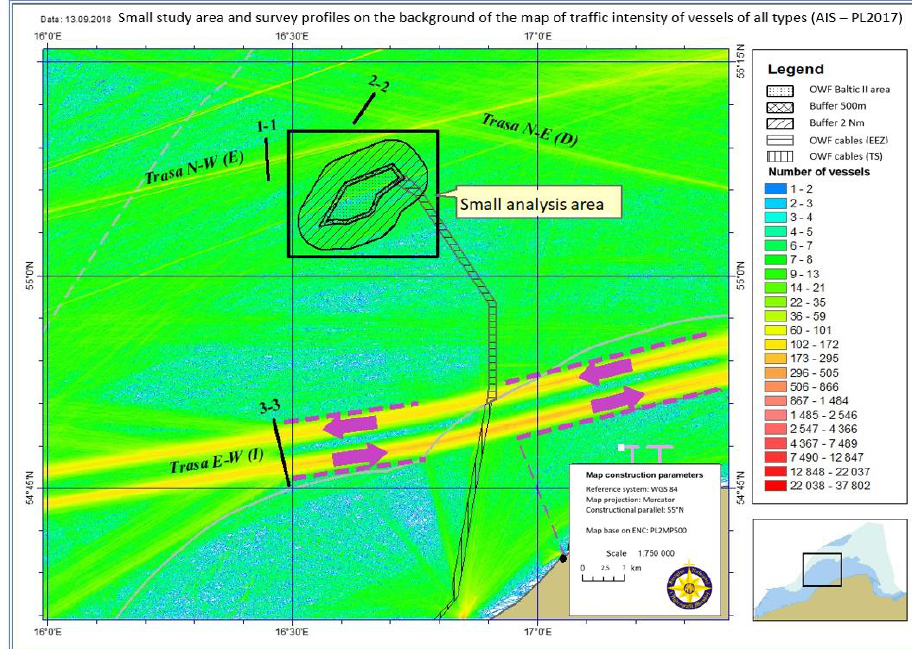
Figure 8. Location of the analyzed area and measurement profiles.